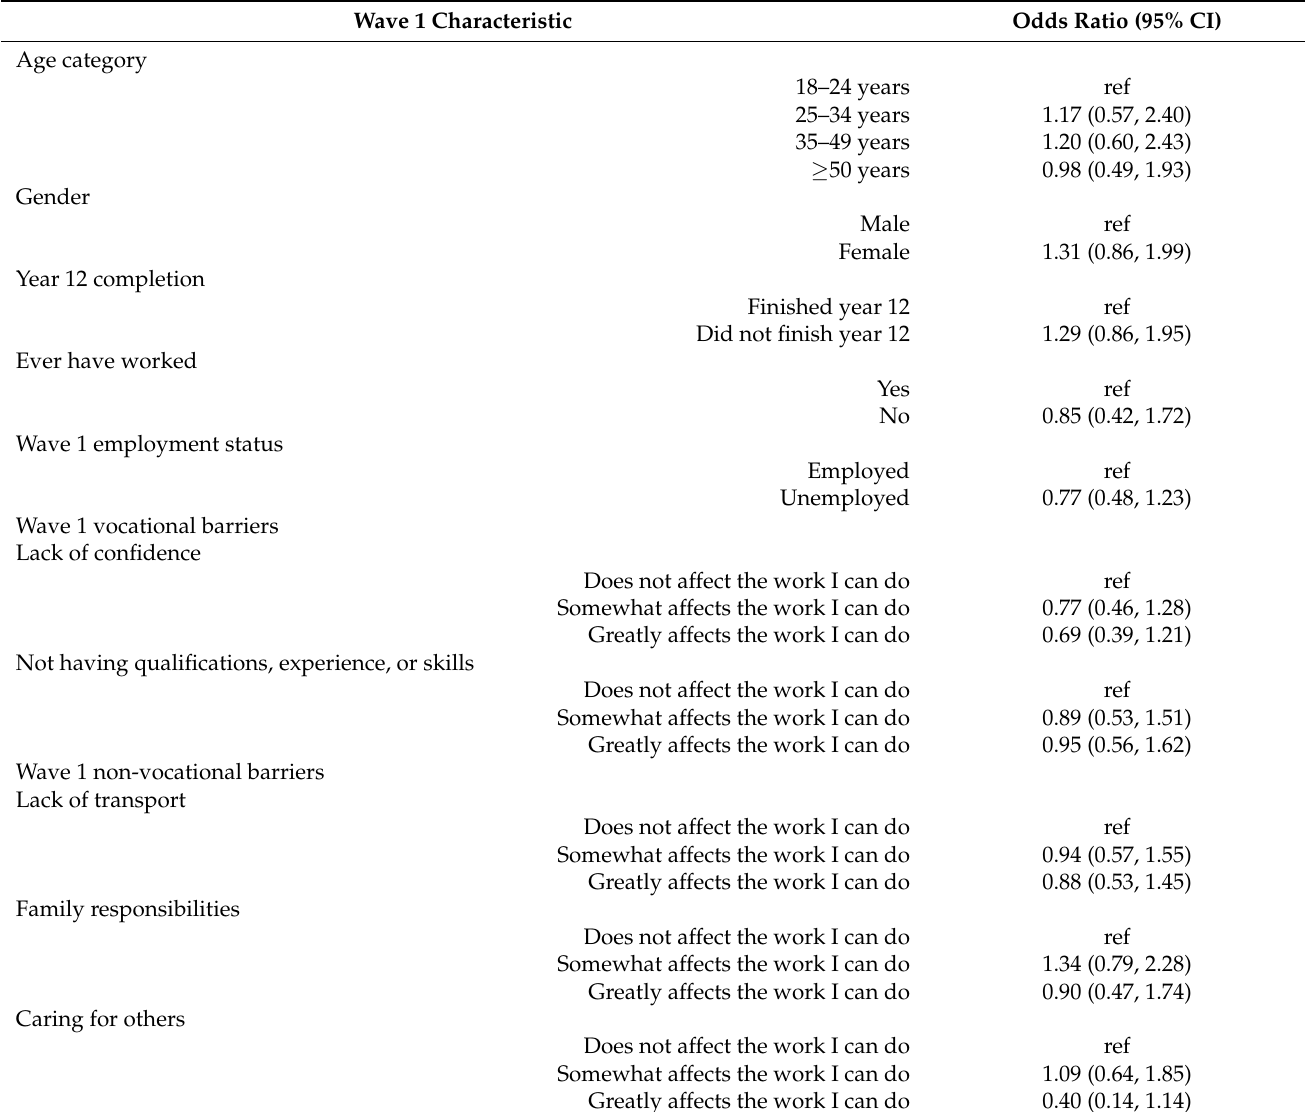
Table A1. Associations between Wave 1 confounders and barriers to work and loss to follow-up at Wave 2. Wave 1 Characteristic Odds Ratio (95% CI) Age